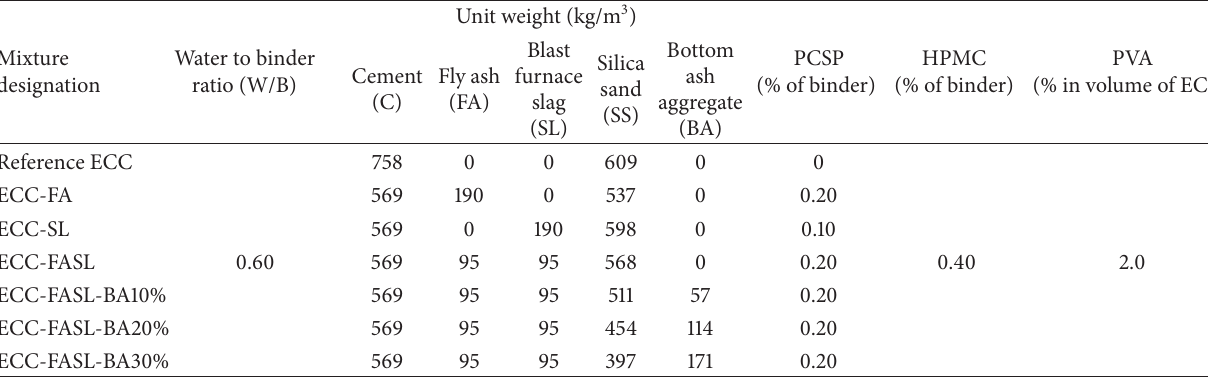
Table 2: Mixture proportions of all ECC mixtures.